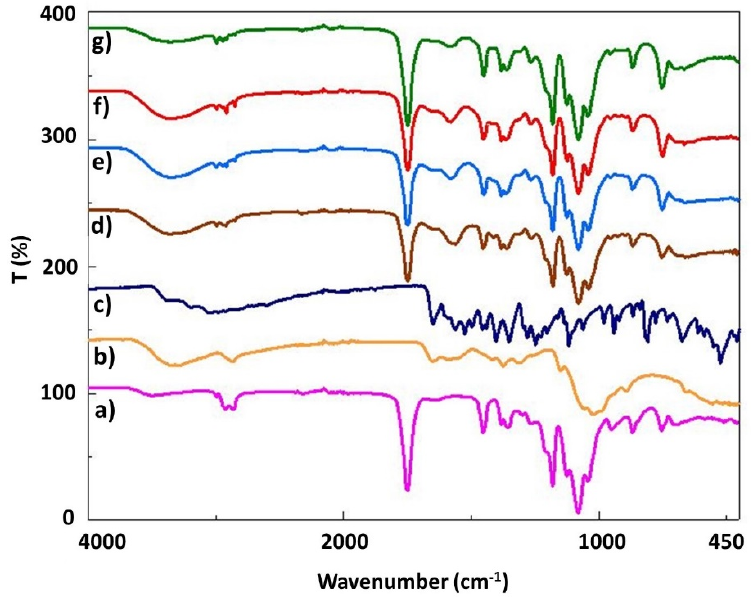
Figure 2. FTIR spectra of the pure PLA ( a ), pure CS ( b ), pure levodopa ( c ), 17 PLA/3 CS ( d ), 17 PLA/3 CS/0.01 LEV ( e ), 17 PLA/3 CS/0.03 LEV ( f ), 17 PLA/3 CS/0.05 LEV ( g ) scaffolds.